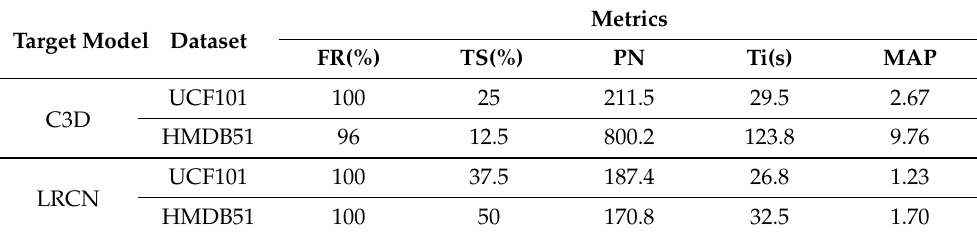
Table 2. Experimental results of white-box